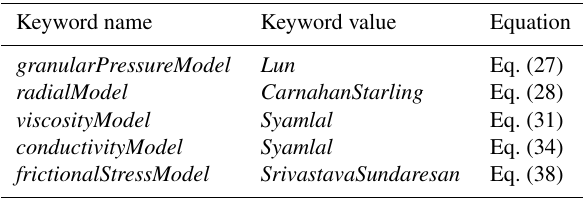
Table 6. List of the kinetic theory closures that can be selected through the different keywords listed in the table together with model equation